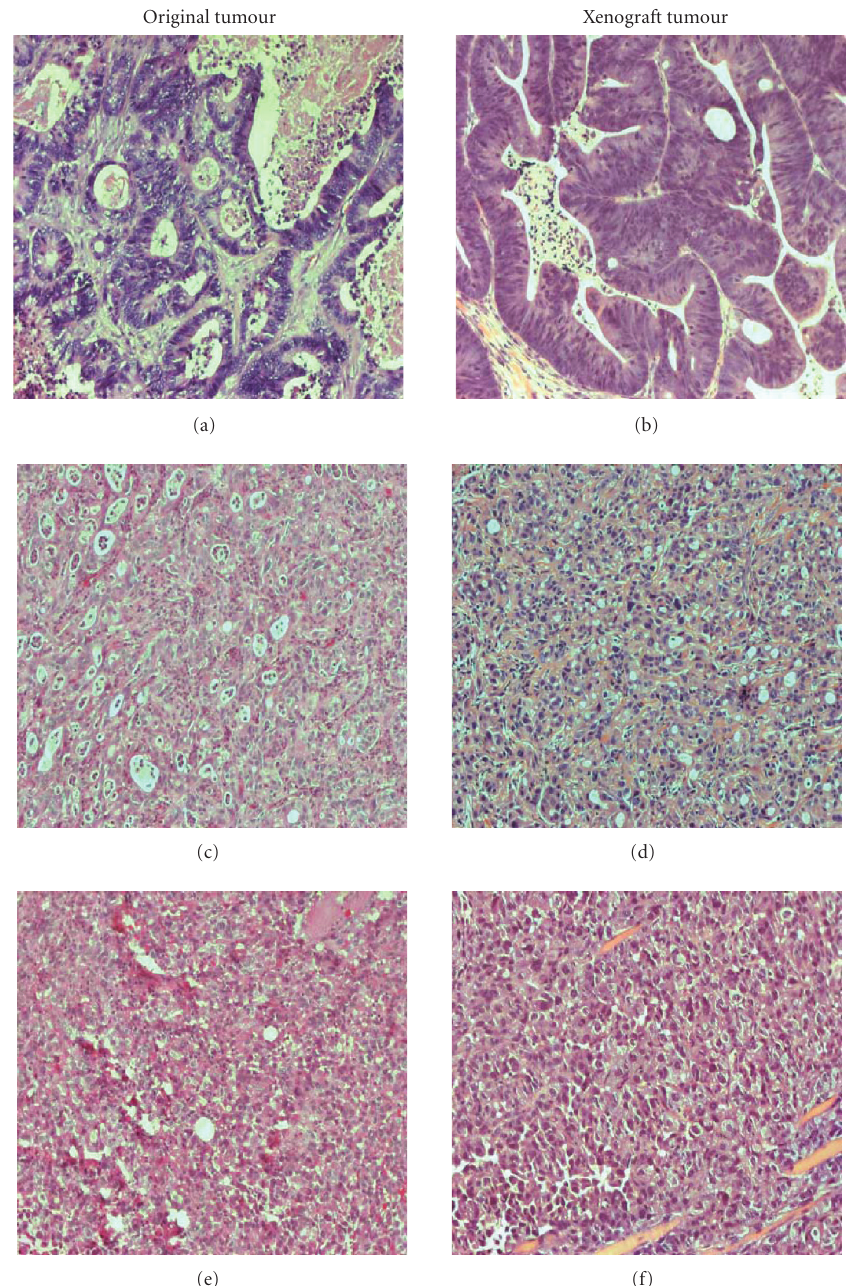
Figure 1: Histological analysis of original and corresponding xenograft tumours. (a) KFJ6 (colorectal liver metastasis) original tumour, (b) KFJ6-derived xenograft tumour, (c) AKH10 (cholangiocellular carcinoma) original tumour, (d) AKH10-derived xenograft tumour, (e) AKH23 (pancreatic adenocarcinoma-derived liver metastasis) original tumour, (f) AKH23-derived xenograft tumour. Sections were stained with haematoxylin and eosin. Magnification: